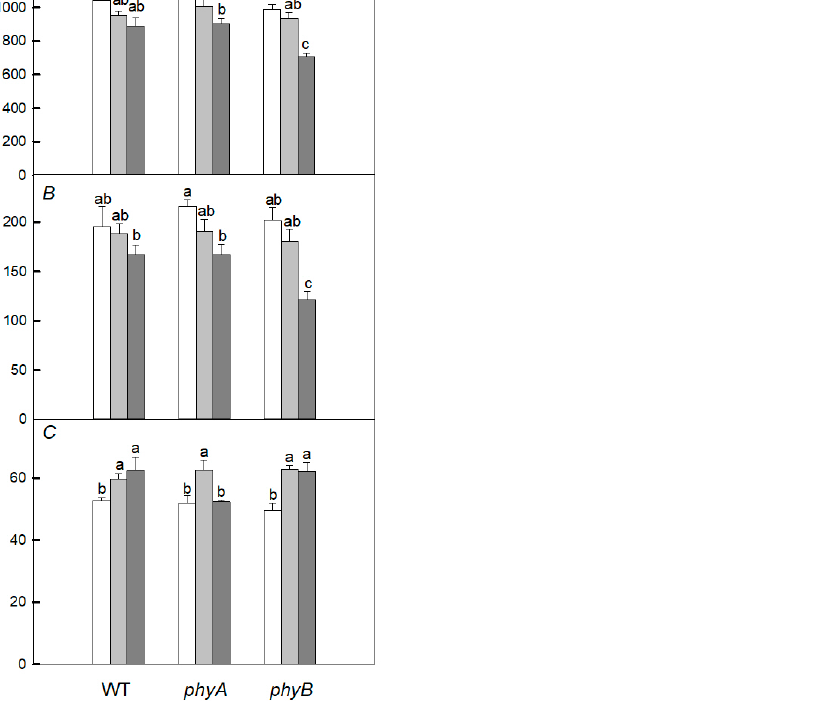
Figure 3. The effect of short-term heating on the content of Chl ( a + b ) ( A ) and carotenoids (Car) ( B )